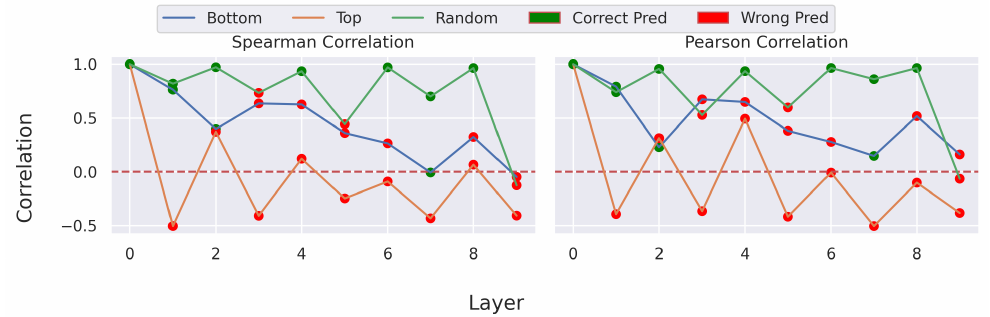
Figure 4. Sanity Correlation. Shows the correlation between the maps with randomized layers and the original attribution map. Refers to the attribution maps shown in Figure 3. The figure shows that changes to the network result in a lower correlation of the attribution map compared to the original attribution